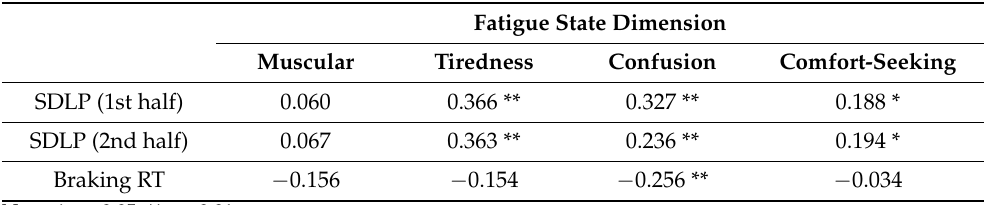
Table 7. Summary statistics for regression of braking RT on experimental factors and DFQ scales.